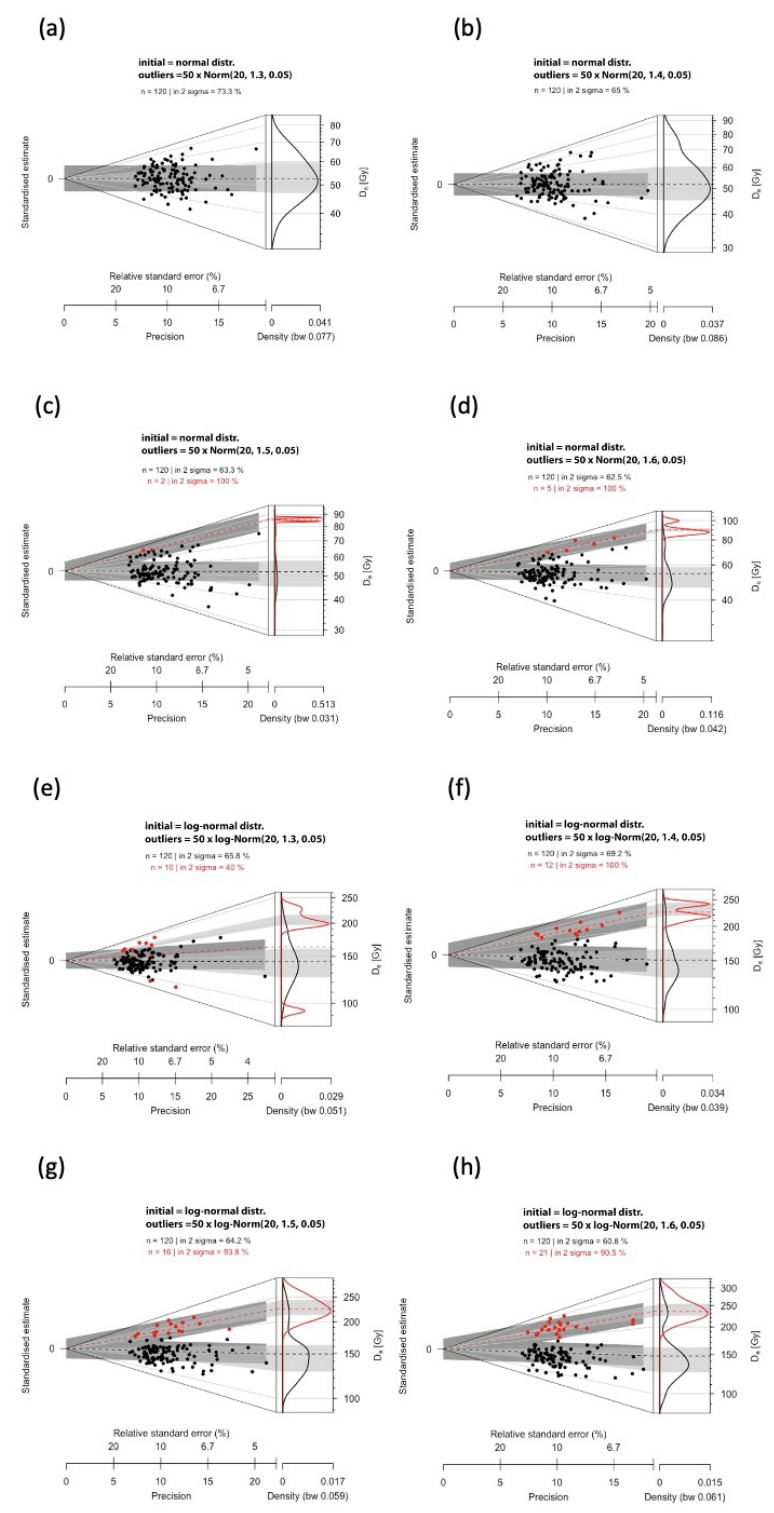
Figure 7. Abanico plots of the D e distributions (100 initial values sampled from the D r distribution) to which 20 outlier values have been added: red dots indicate the values identified as outliers (not the values added as outliers). (a–d) Initial D e distribution = normal distribution; (e–h) initial D e distribution = log-normal distribution. Outlier values (20) added as follows: (a) 50 × Norm(20, 1.3, 0.05); (b) 50 × Norm(20, 1.4, 0.05); (c) 50 × Norm(20, 1.5, 0.05); (d) 50 × Norm(20, 1.6, 0.05) and (e) 50 × log-Norm(20, 1.3, 0.05); (f) 50 × log-Norm(20, 1.4, 0.05); (g) 50 × log-Norm(20, 1.5, 0.05); (h) 50 × log-Norm(20, 1.6, 0.05). Geochronology, 4, 297–310, 2022